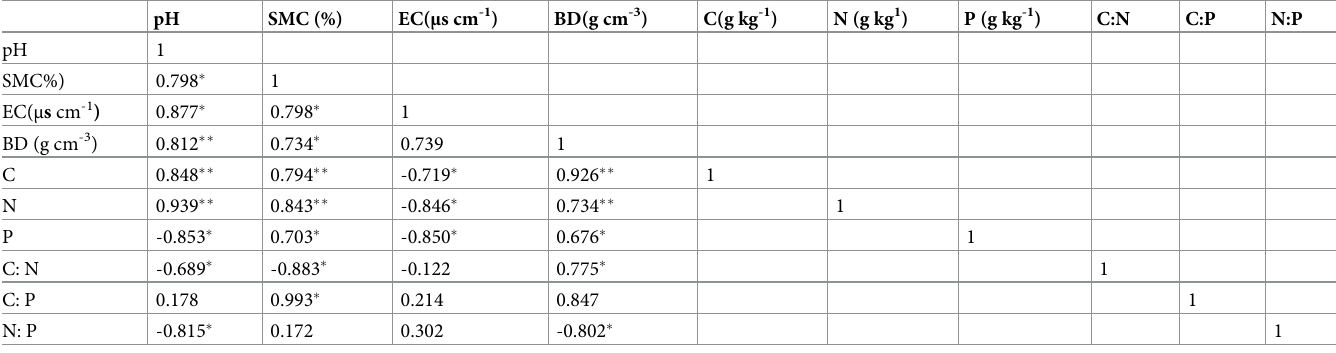
Table 4. Pearson correlation analysis (2-tailed) result between soil ecological stoichiometric characteristics and environmental variables. pH SMC (%)